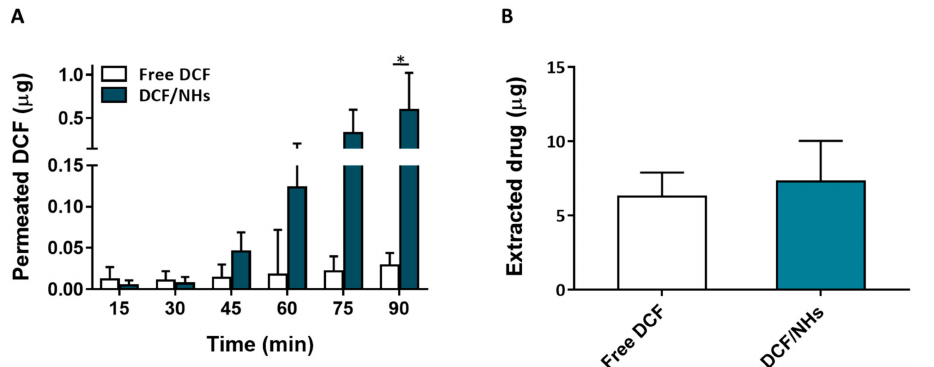
Figure 6. Ex vivo transcorneal permeation profile of DCF/NHs and free DCF ( A ). Corneal retention values of DCF comparing drug-loaded NHs and free drug solutions after 1.5 h of incubation ( B ). Asterisk denote statistically significant difference. The one-way analysis of variance (ANOVA) was carried out followed by Tukey’s multiple comparisons, and statistically significant differences were identified when p -values were lower than 0.05 (* p <